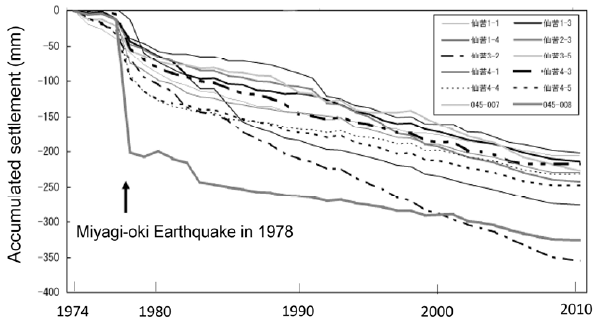
Figure 1. Examples of land subsidence variation in Sendai before and after the earthquake.